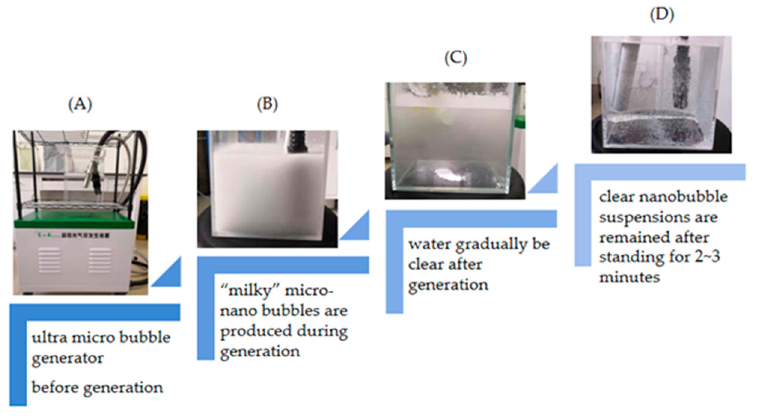
Figure 1. Procedure of nanobubble generation. ( A ) Before generation; ( B ) During generation of micro-nano bubbles; ( C ) Stop the generation of bubbles; ( D ) After standing for 2 to 3 minutes.